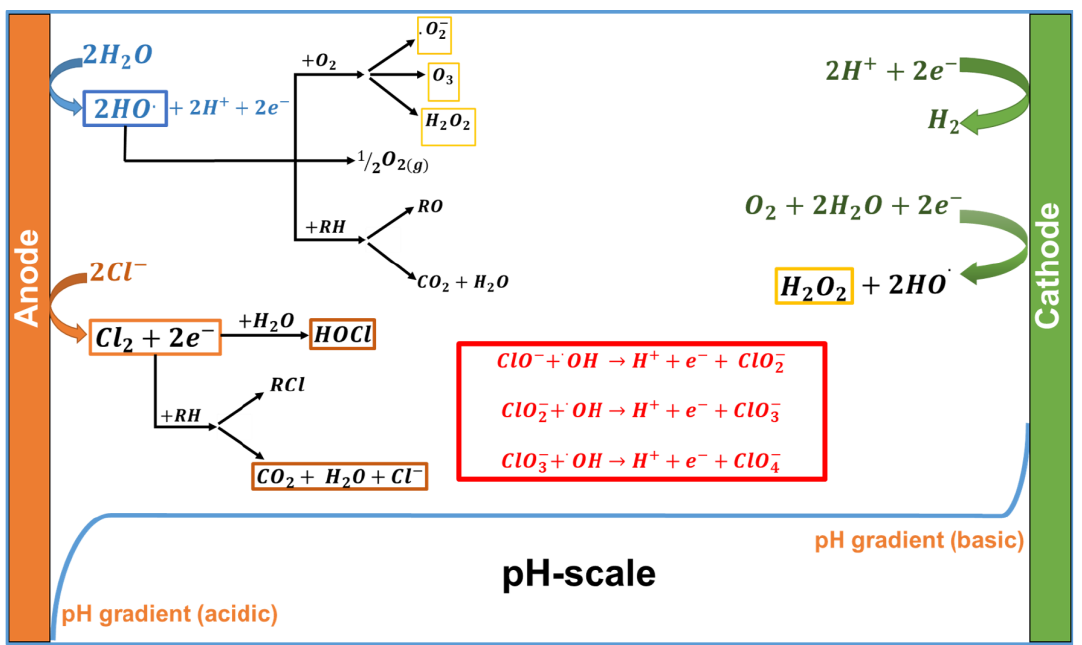
Figure 6. Oxidants generated in situ within the EC reactor during the EC treatment involving the elimination of organic compounds and disinfection of microorganisms present in BW. Hydrogen and other oxidants generated at the cathode side are indicated using the green-colored arrow. Apart from that, the rest of the oxidants are produced on the anode side.